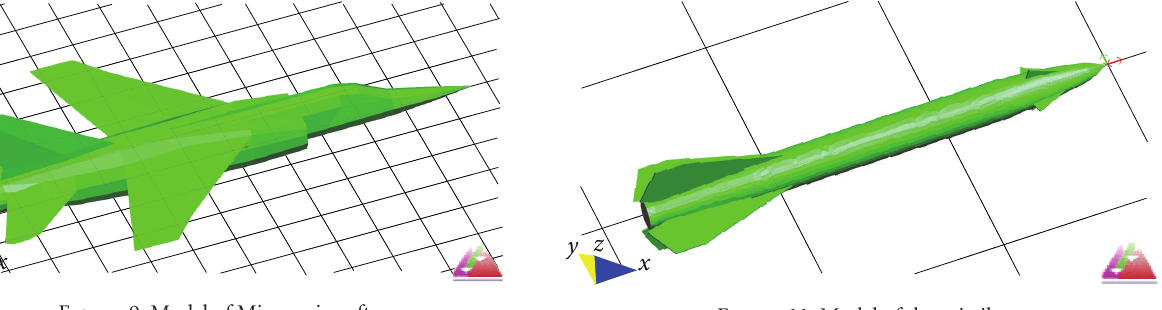
Figure 11: Model of the missile.